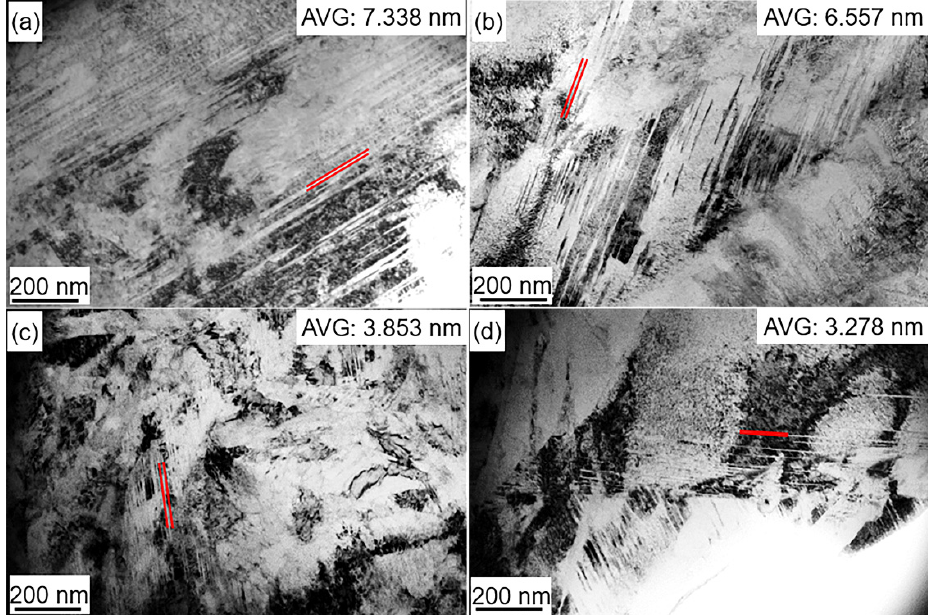
Figure 9. TEM micrographs of twin martensite in ( a ) Q, ( b ) D 5min , ( c ) D 5h , and ( d ) D 12h (AVG: average value).